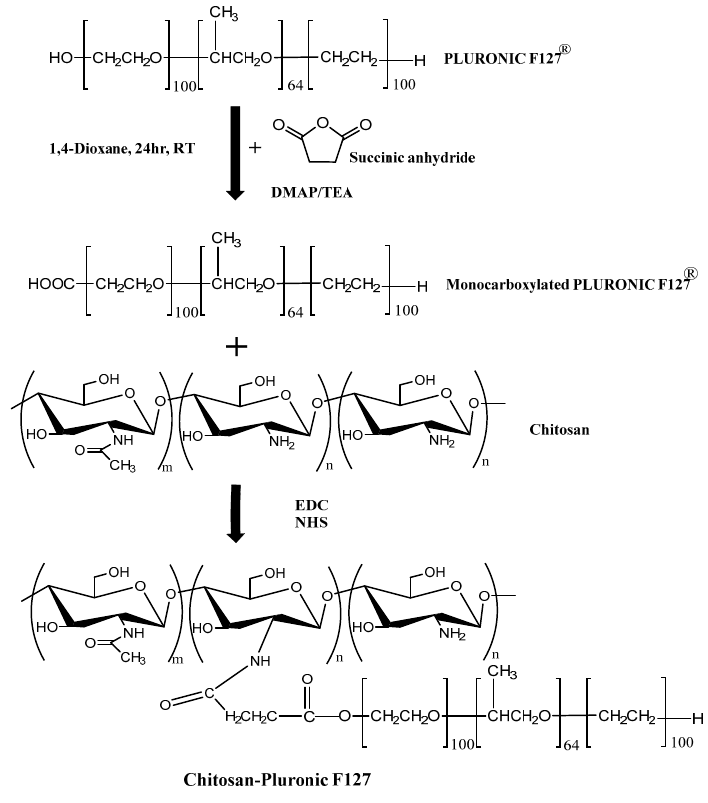
Figure 6. Synthetic route of Pluronic F127-Chitosan using EDC/NHS.